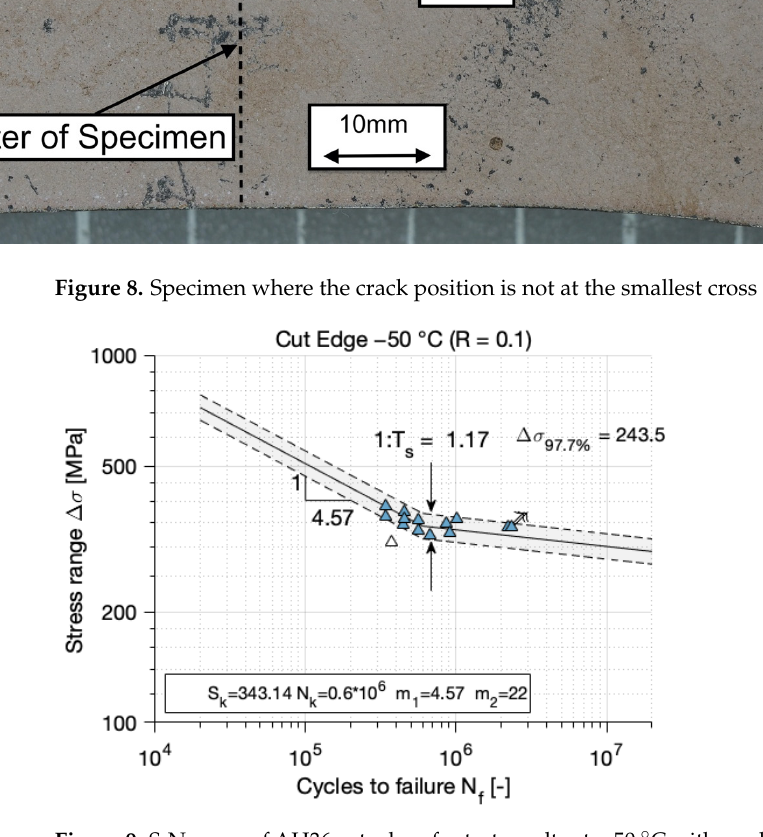
Figure 9. S-N curve of AH36 cut edges for test results at − 50 °C with modified stress ranges evaluated with the maximum likelihood method. The white triangle shows the outliner.